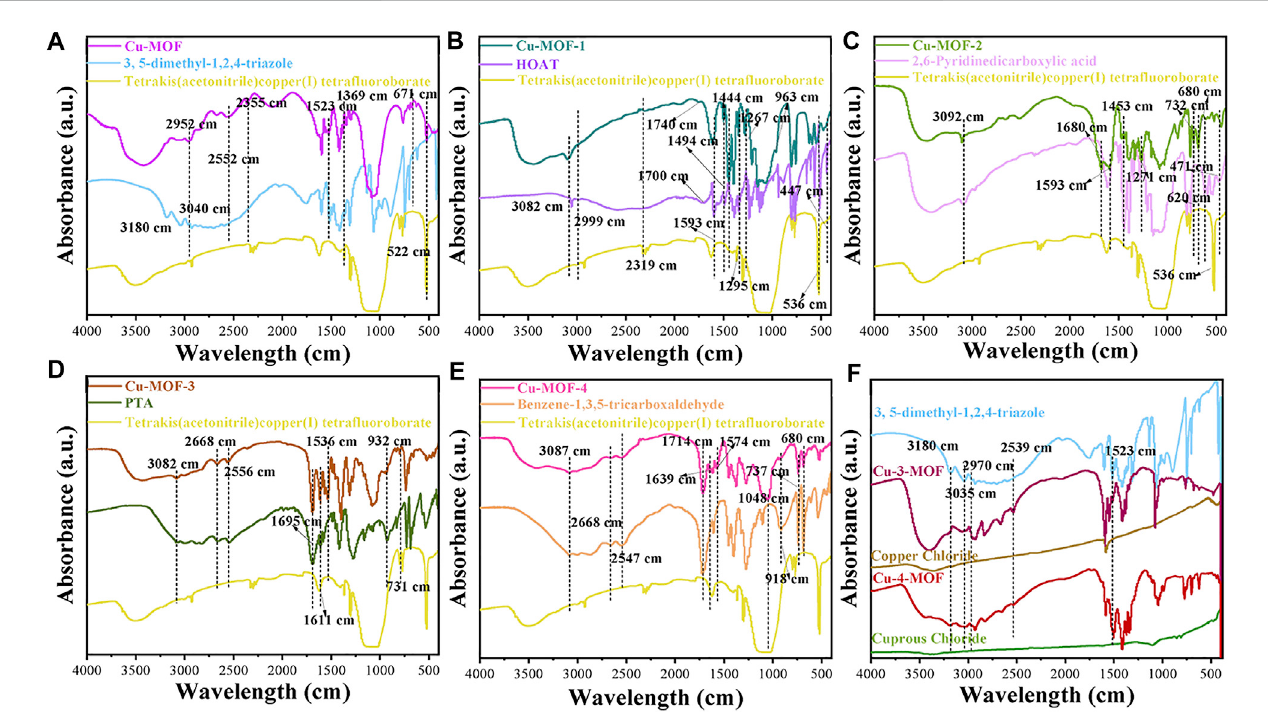
FIGURE 3 FTIRspectraof (A) Cu-MOF, (B) Cu-MOF-1, (C) Cu-MOF-2, (D) Cu-MOF-3,and (E) Cu-MOF-4withtheirorganicligandsof3,5-dimethyl-1,2,4-triazole, HOAT, 2,6-pyridinedicarboxylic acid, PTA and benzene-1, 3, 5-tricarboxaldehyde, and metal source of tetrakis (acetonitrile) copper (I) tetra fl uoroborate, respectively, and (F) Cu-3-MOF and